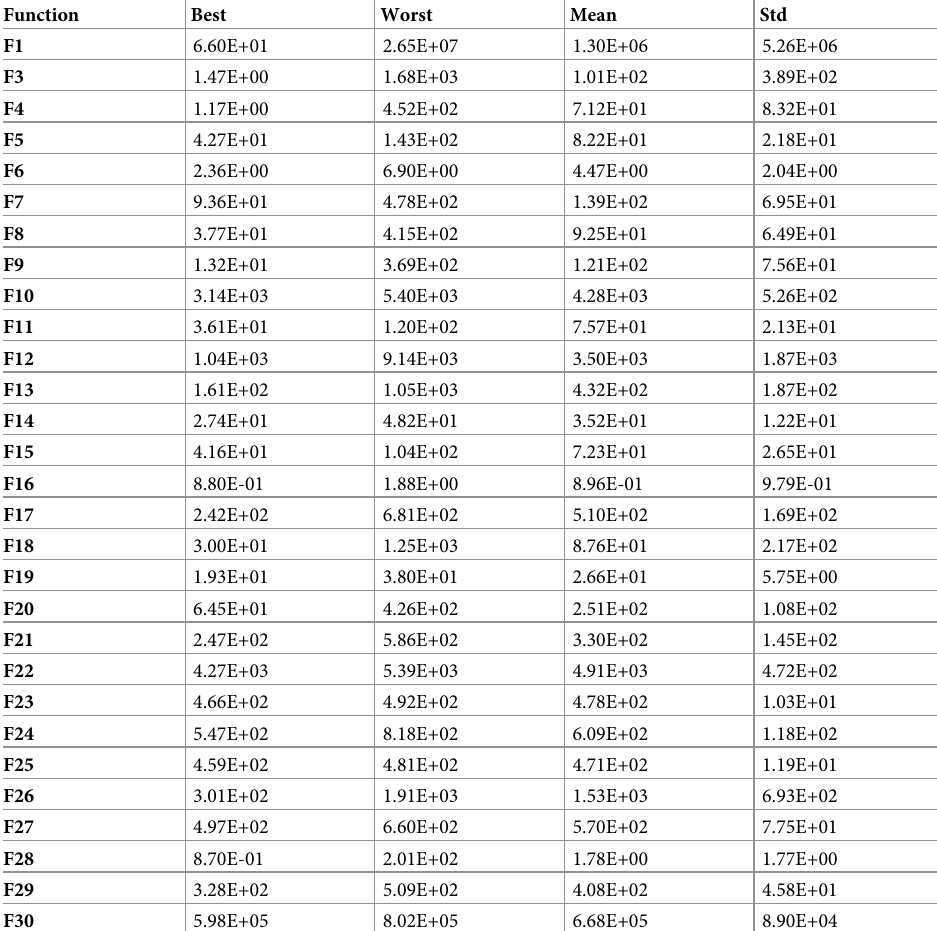
Table 9. Results for ADMO in 100